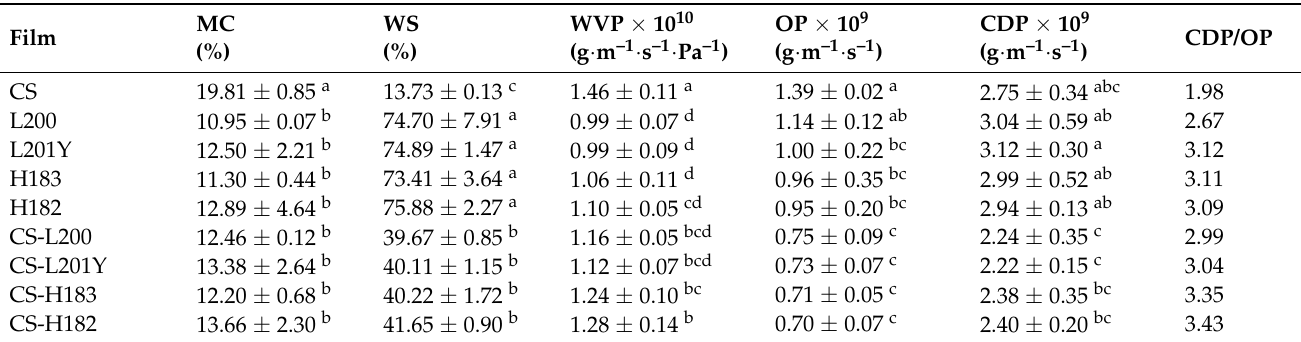
Table 3. Moisture content, water solubility, and barrier properties of different monolayer and bilayer